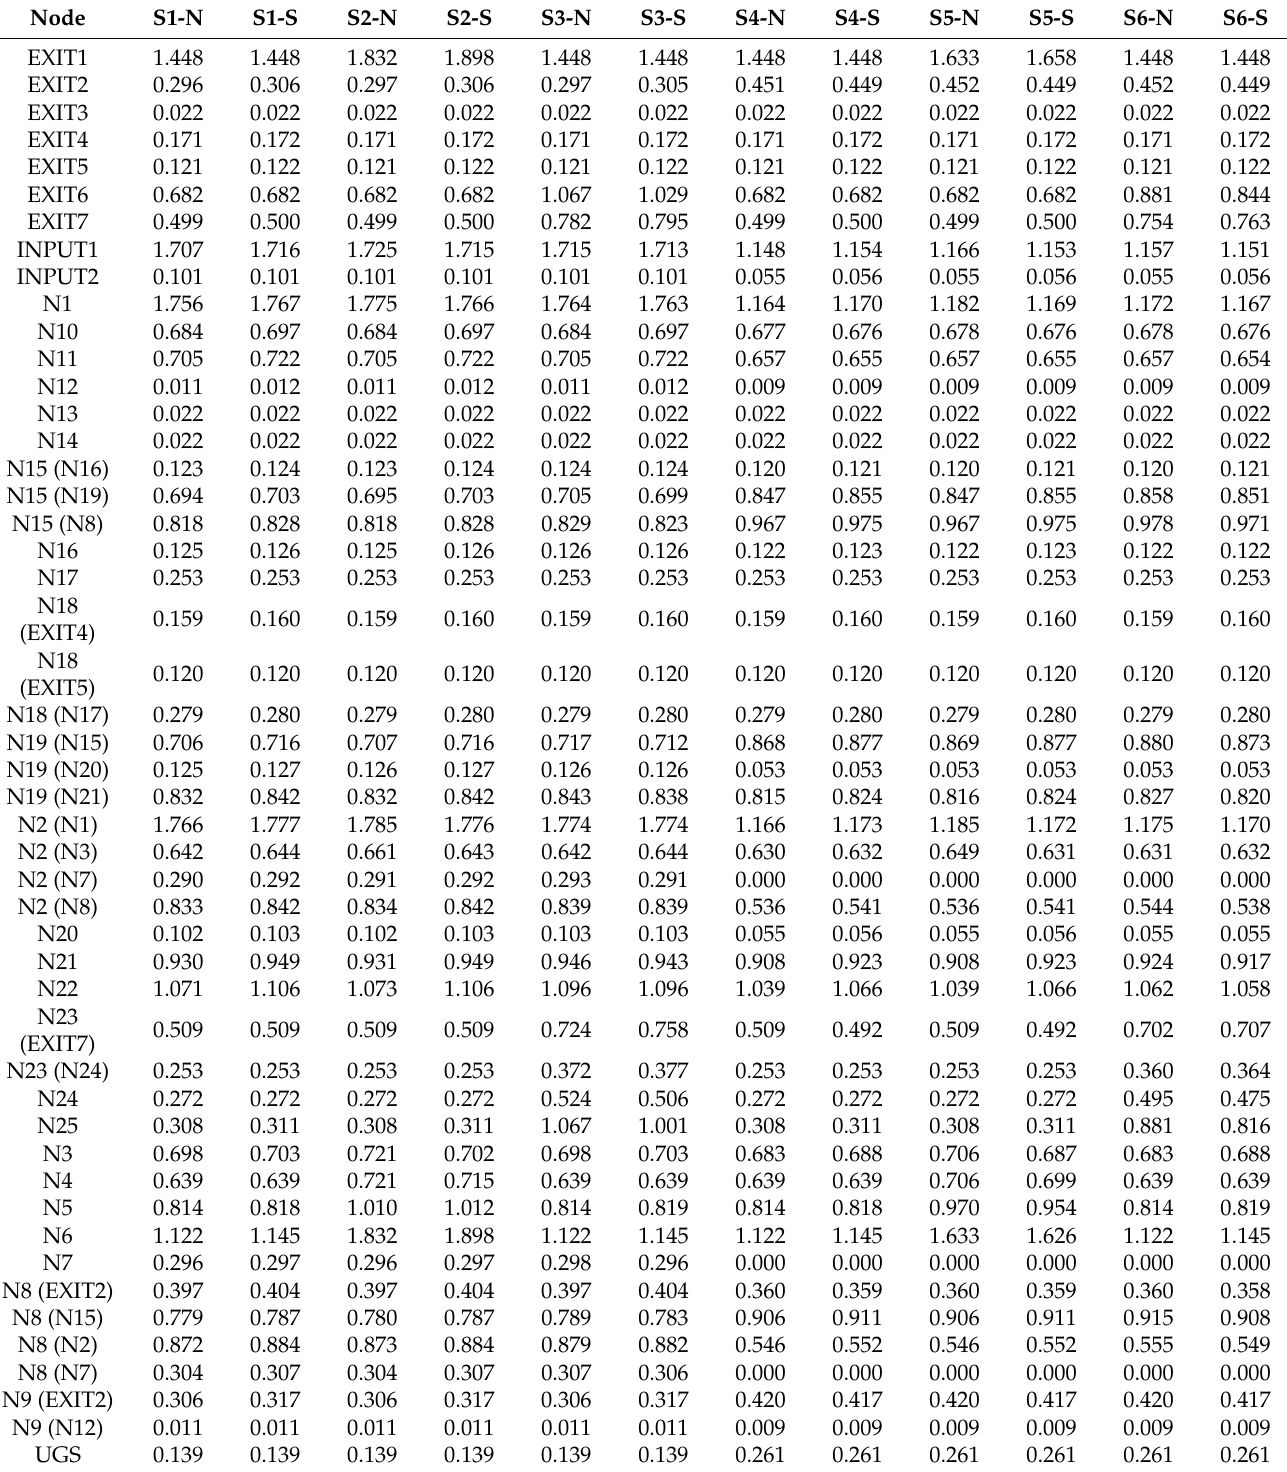
Table 6. Results of simulation in case study 1—volumetric gas flows (m 3